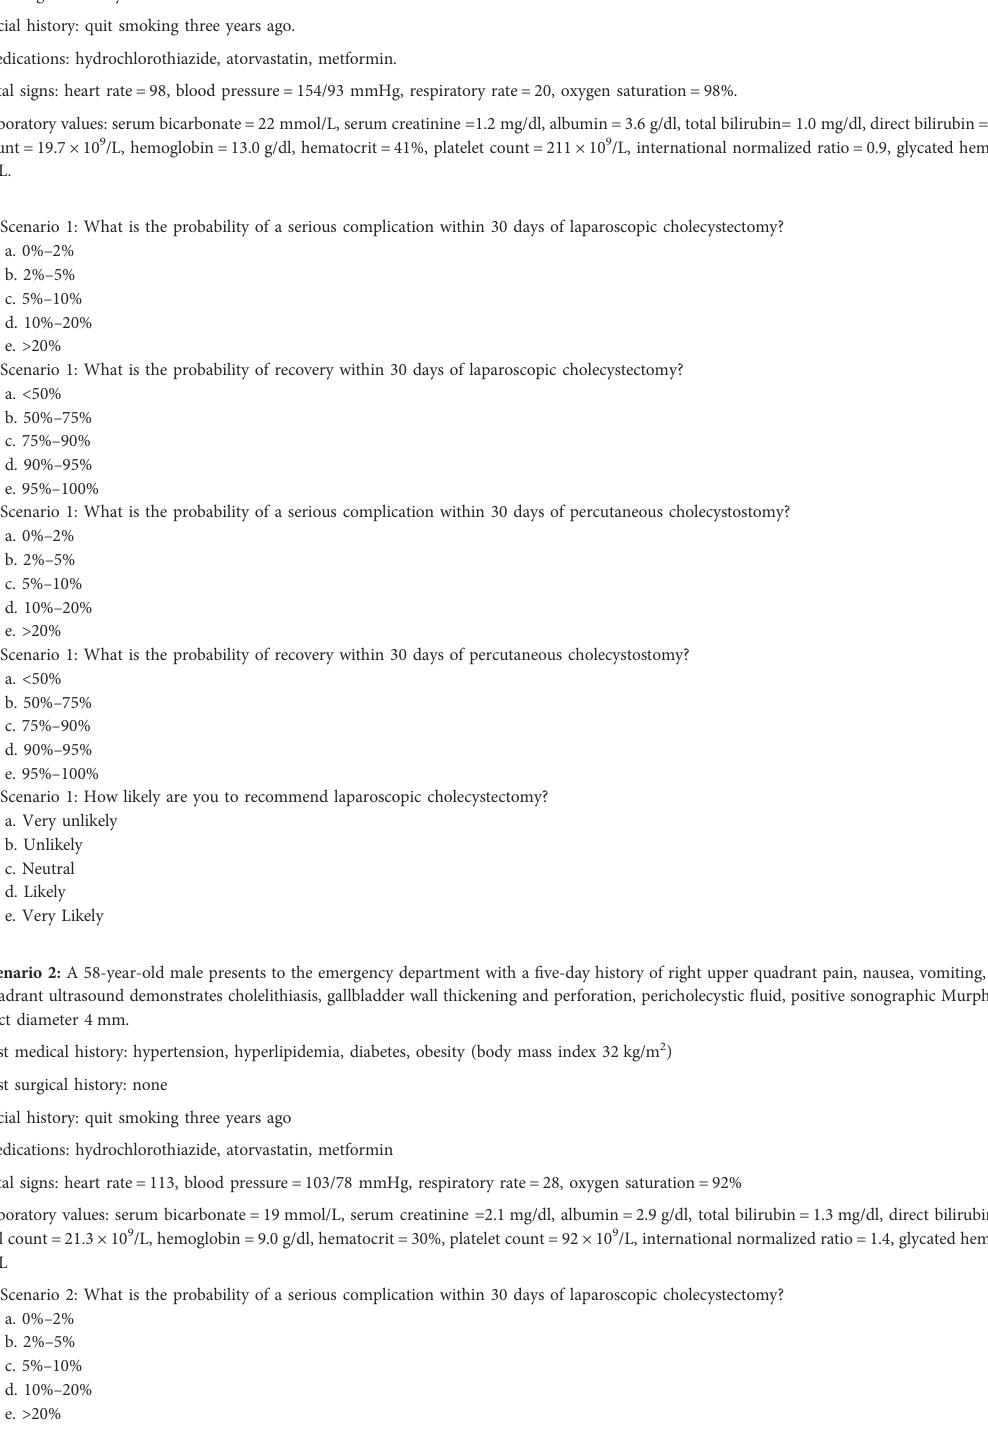
TABLE 1 Clinical